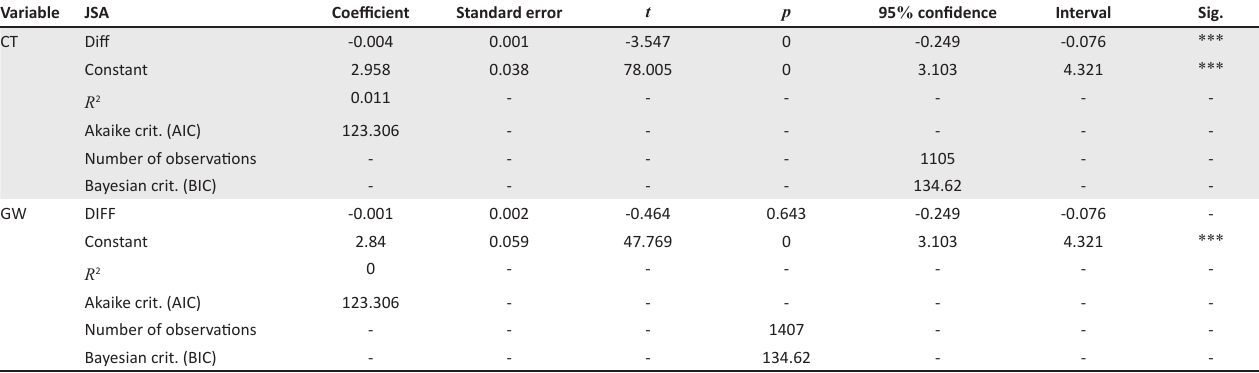
TABLE 3: Linear regression result of creative talents and general workers. Variable JSA